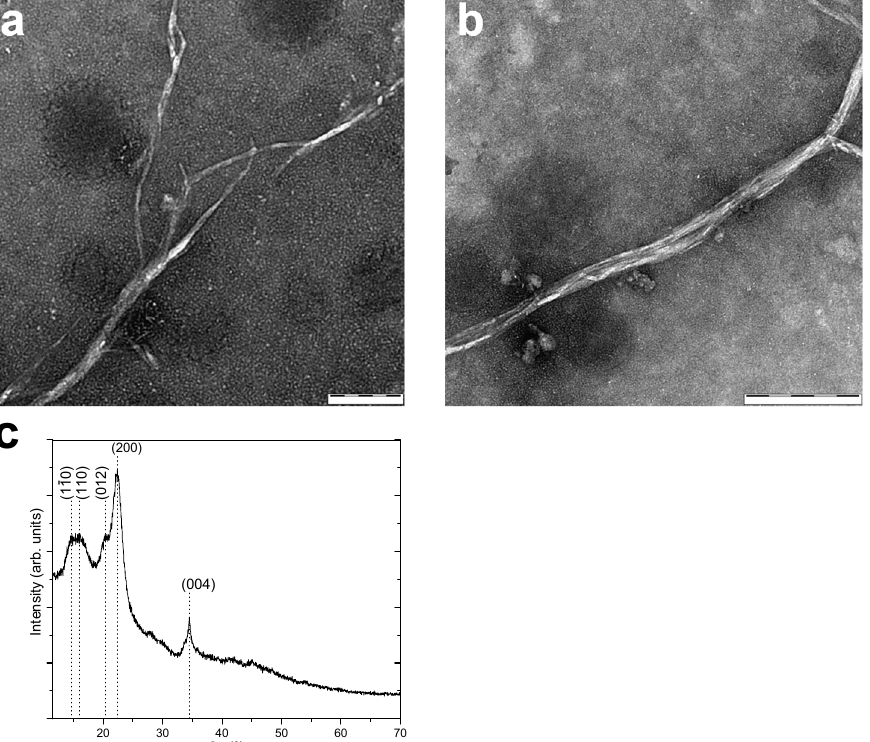
Figure 1. ( a , b ) TEM images of cellulose nanofibers (CNFs) at different magnifications. Scale bars: ( a ) 100 nm; ( b ) 200 nm. ( c ) Wide angle X-ray diffraction pattern of the CNFs, with indexed crystallographic planes of native cellulose I allomorph.